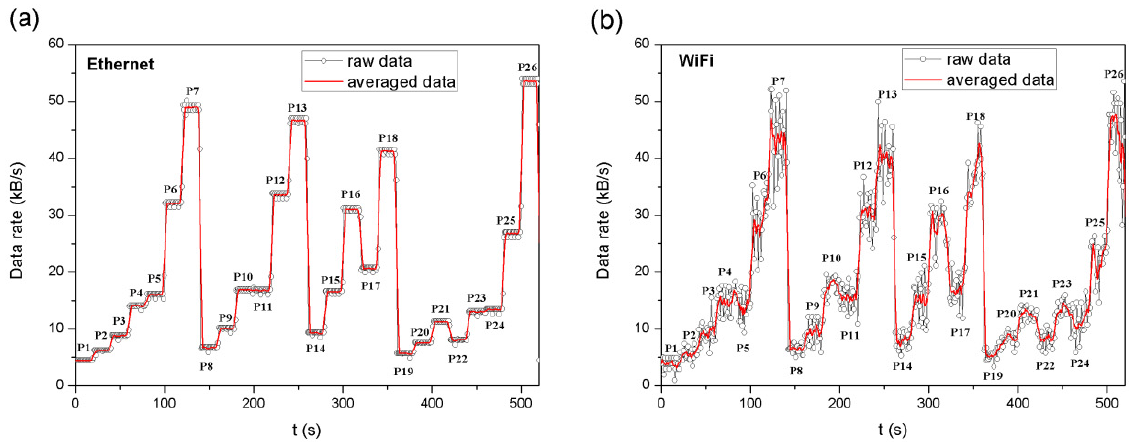
Figure 11. Changes in data rate for defined measurement cases: ( a ) for Ethernet frames and ( b ) for Wi-Fi frames.